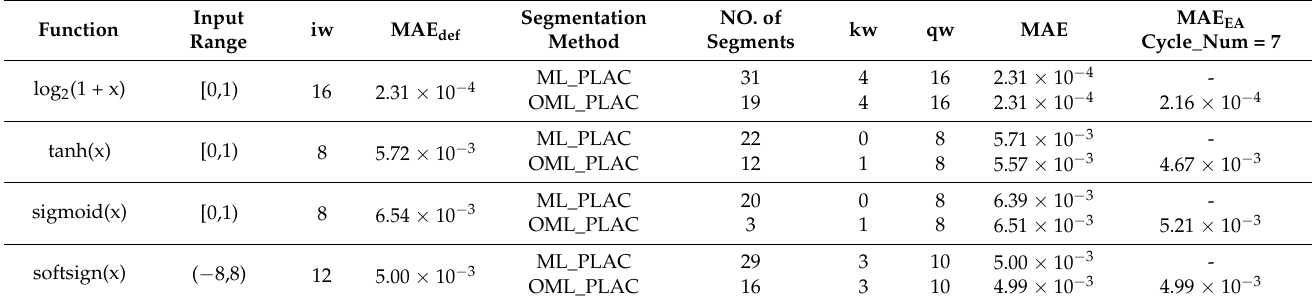
Table 3. Segmentation performance comparison between OML-PLAC and the method used in